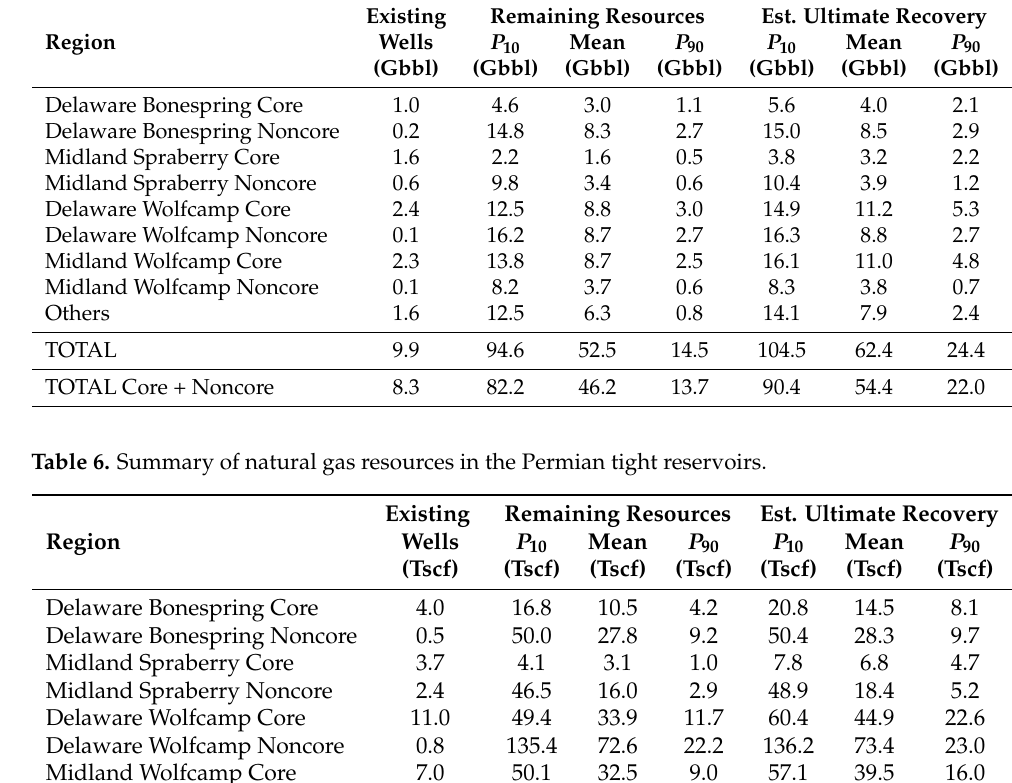
Table 5. Summary of crude oil resources in the Permian tight reservoirs.